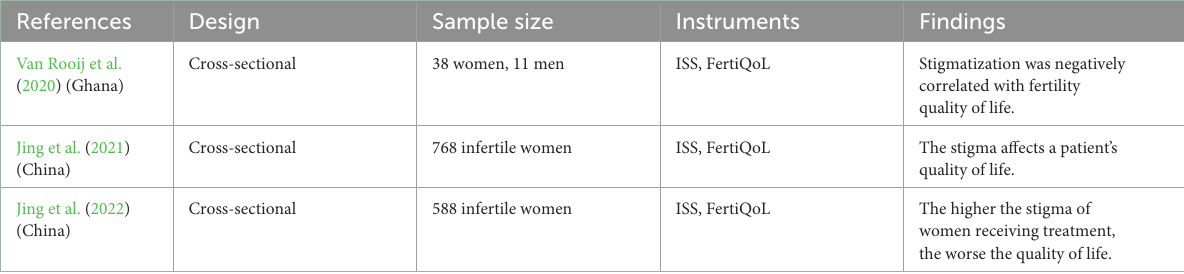
TABLE 4 Summary of the qualitative studies.